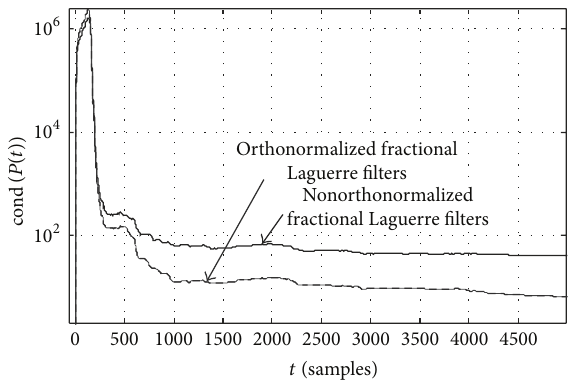
Figure 3: Conditioning of the covariance matrix versus time; Example